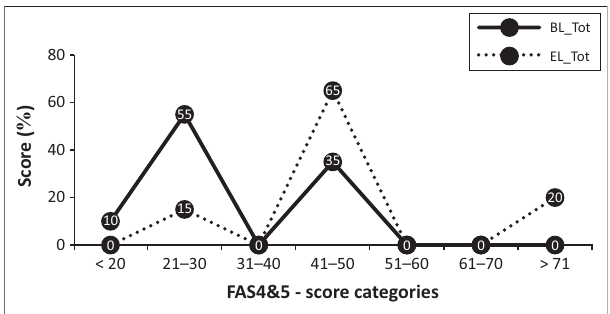
FIGURE 4: Formative assessment strategy 3 frequency score distribution.